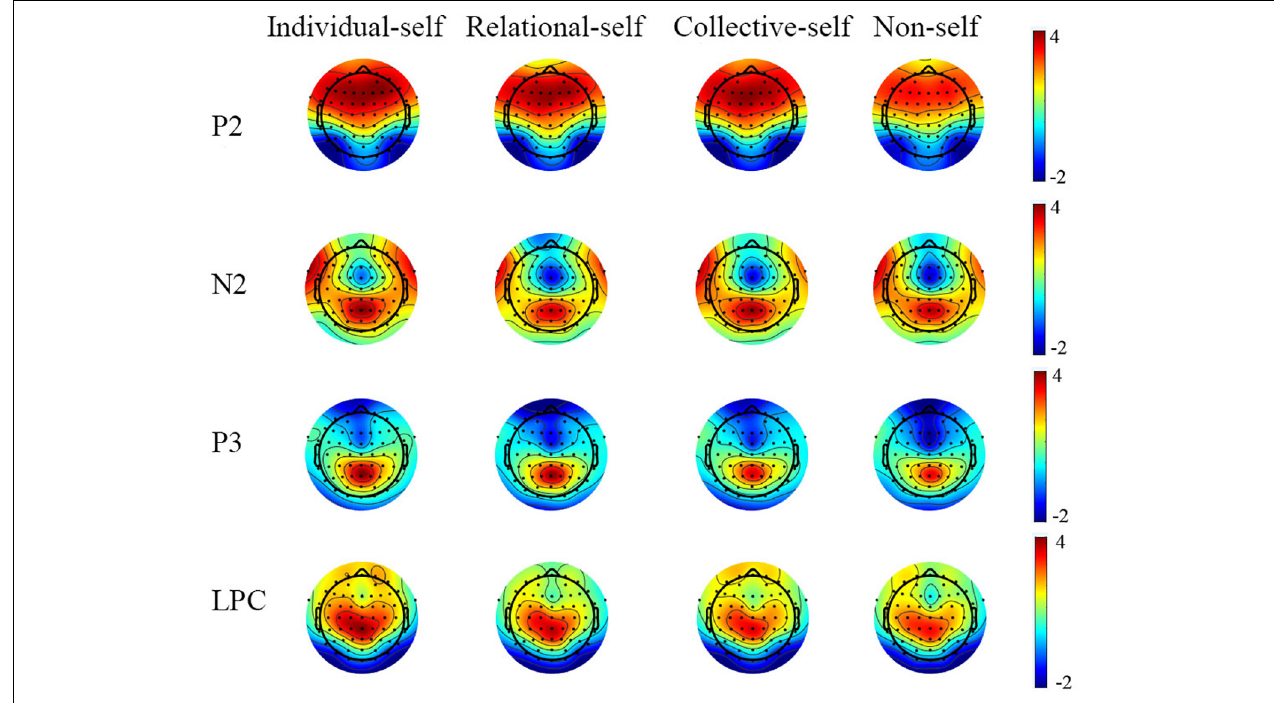
FIGURE 3 | Topography plots of P2, N2, P3, and LPC for the individual self, relational self, collective self, and non-self during the matched